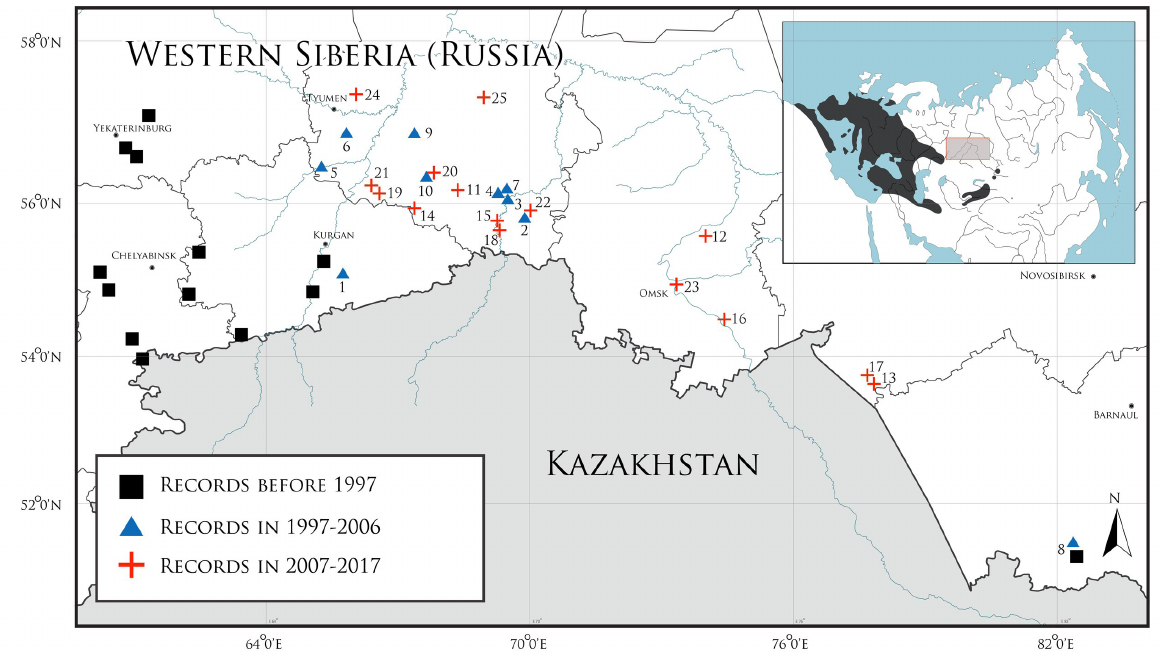
Figure 3. Dynamics of the distribution of Calosoma sycophanta (Linnaeus, 1758) in Western Siberia. Numbers correspond to the records in Table 1. Top right: the area in Palearctic (dark fill) (Krizhanovskii